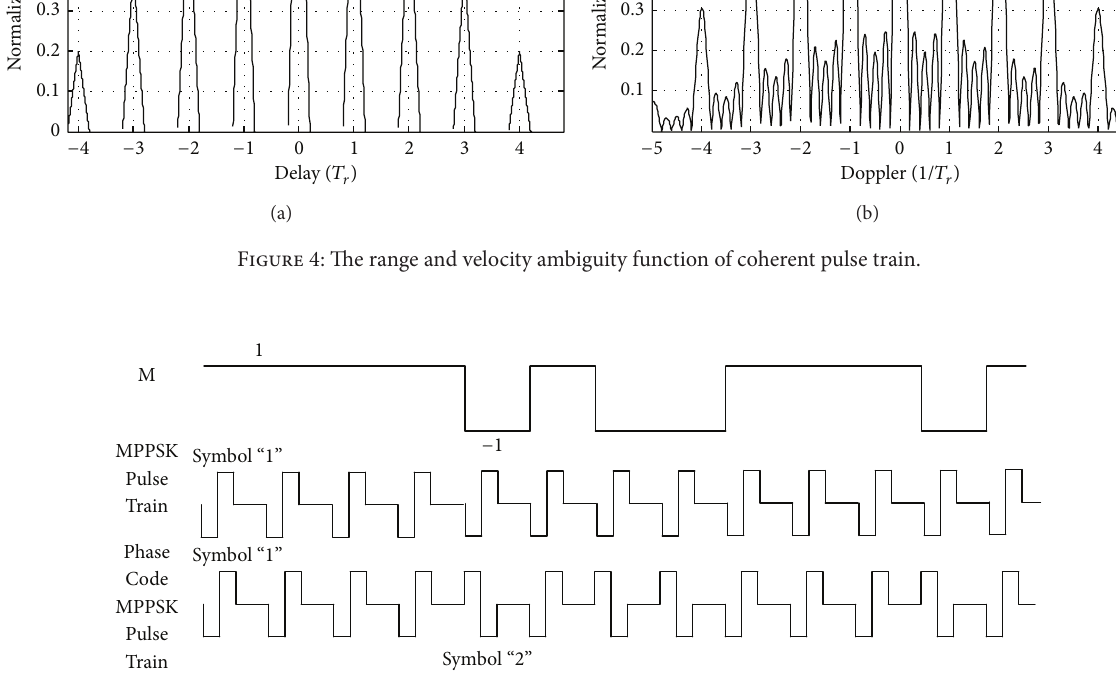
Figure 5: HRF biphase code MPPSK pulse